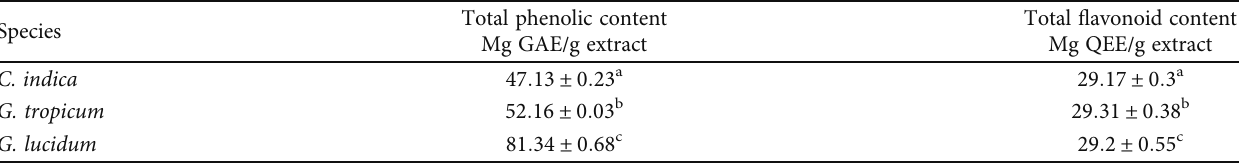
Table 2: Total phenolic and fl avonoid content in ethanolic extracts of the three mushroom